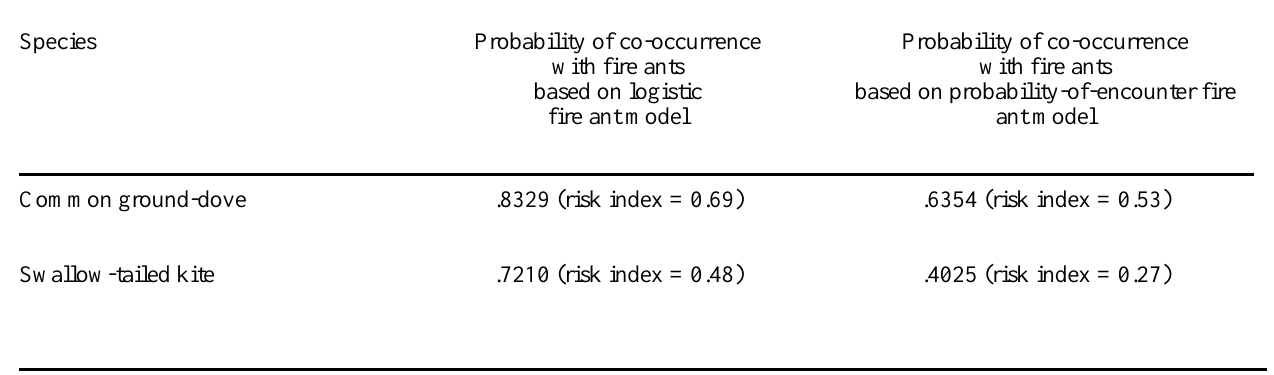
Table 3. Probability of spatial co-occurrence for two at risk species and fire ants in South Carolina as quantified by using a logistic regression derived fire ant distribution model and a probability of encounter fire ant distribution model. Overall risk index, shown in parentheses, is calculated as the product of the probability of co-occurrence and the hazard